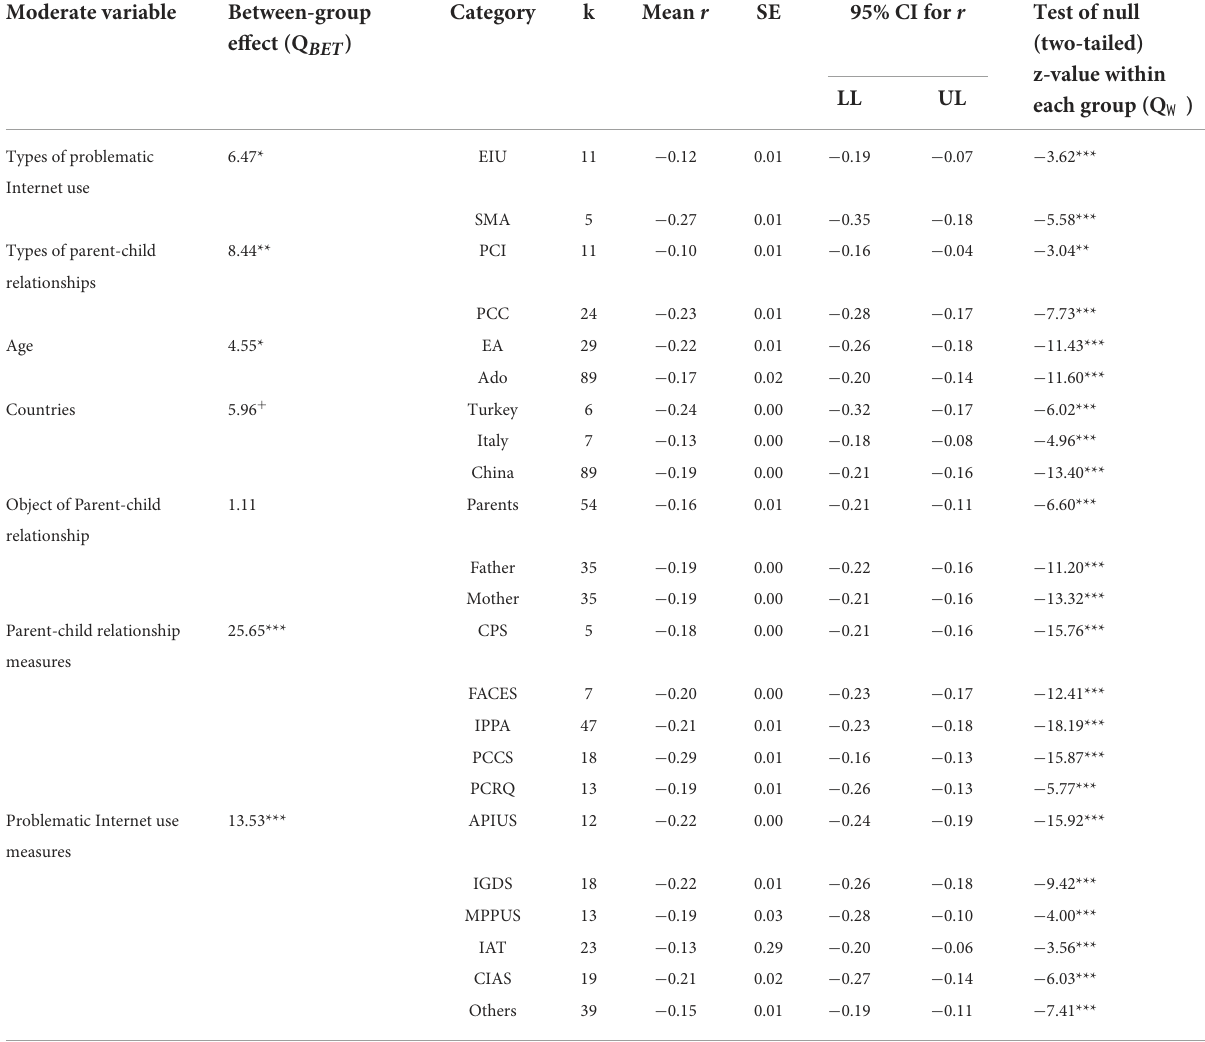
TABLE 3 Moderator analysis of correlations between parent-child relationship and problematic Internet use. Moderate variable Between-group Category k Mean r 95% CI for r Test of null effect (Q BET )